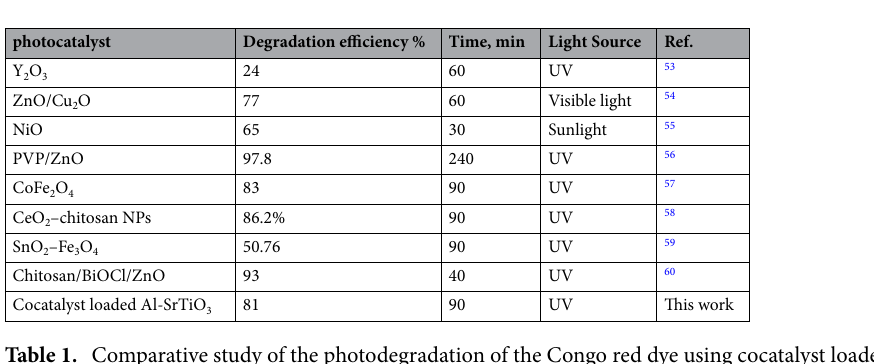
Table 1. Comparative study of the photodegradation of the Congo red dye using cocatalyst loaded Al-SrTiO 3 and the other photocatalysts.